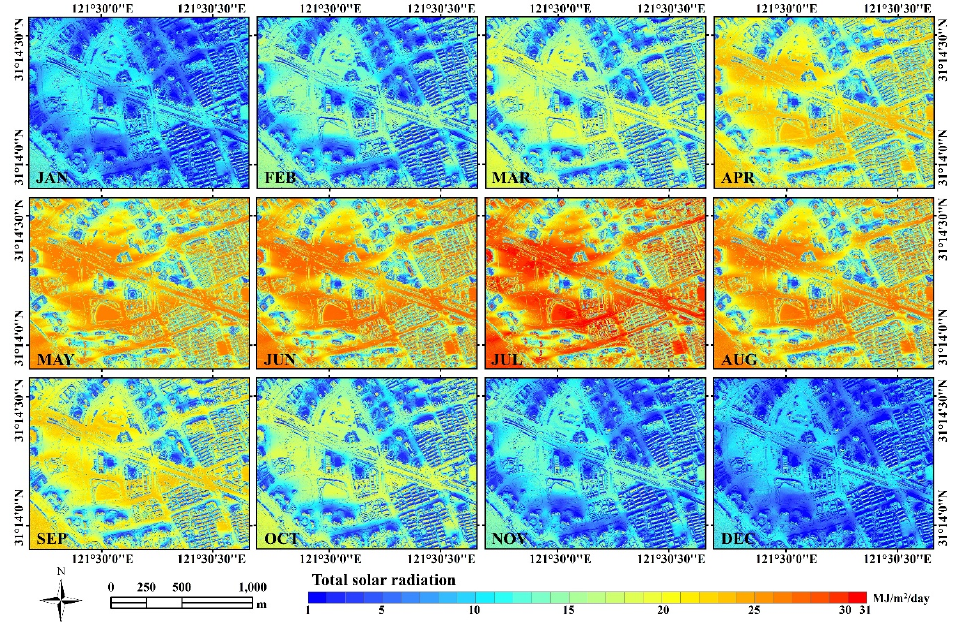
Figure 3. Monthly average total solar radiation distribution estimated by SHORTWAVE-C model in the Lujiazui region.